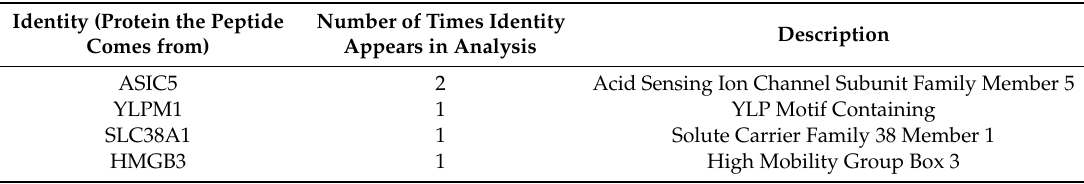
Table 3. Detailed predicted neoepitopes in both stages of the disease. Predicted neoepitopes in stabilized disease.